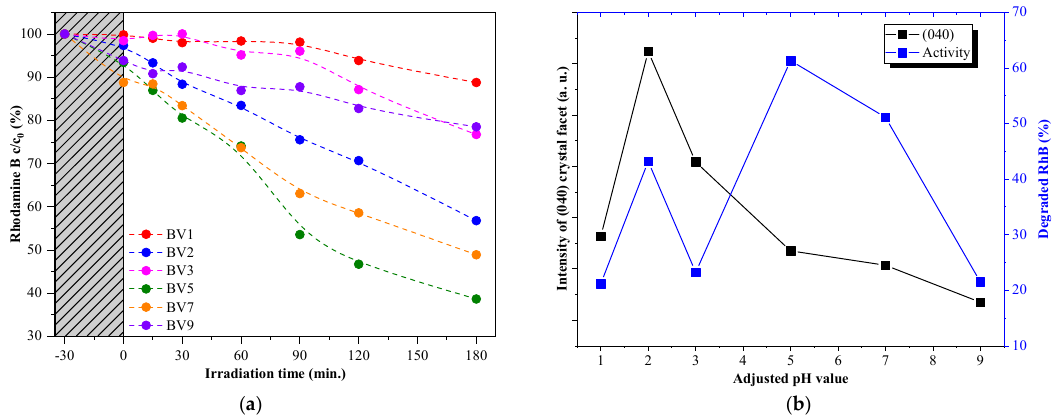
Figure 5. The photocatalytic activity of the samples in case of rhodamine B under visible light irradiation ( a ) and the activity trend similarity with the trend of (040) crystallographic plane’s dominance ( b ). Please note that the lines used to connect the data points are only there to increase the readability of the figure and do not represent any mathematical trends or equation fittings.